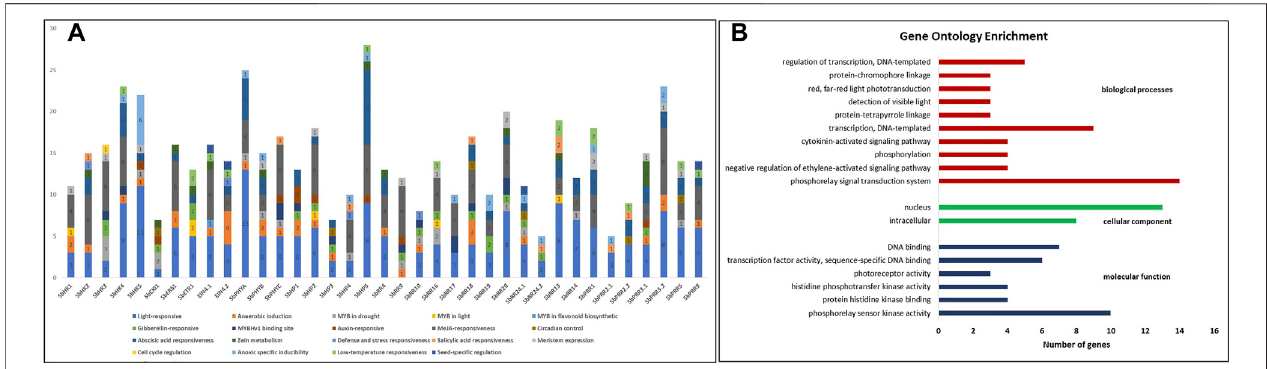
FIGURE 5 | (A) Graphical representation of cis -regulatory elements presents in putative TCS promoter ’ s region. Different colors are representing different cis- elementsand numbers inbars represent number ofelements. (B) Gene ontology enrichmentstatistics graph, red colorbar represents biologicalprocesses, green color bar represents cellular component, and blue color bar represent molecular